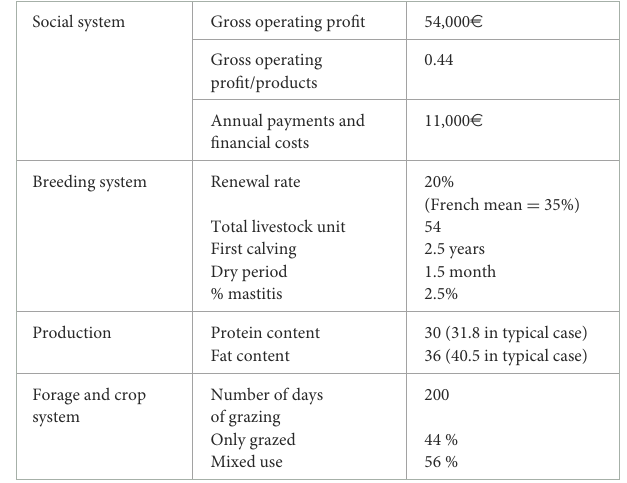
TABLE 1 Economical and technical figures of M. Henri’s